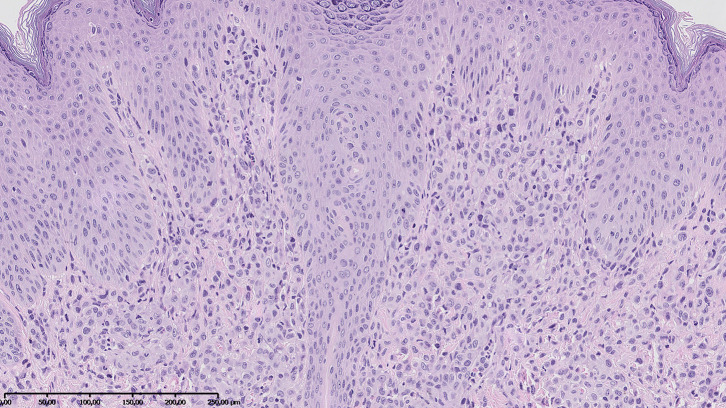
Skin biopsy revealed diffuse infiltration by histiocytes positive for CD45 and CD68 and negative for S100 and CD1a. Hematoxylin–eosin stain; magnification, ×10.